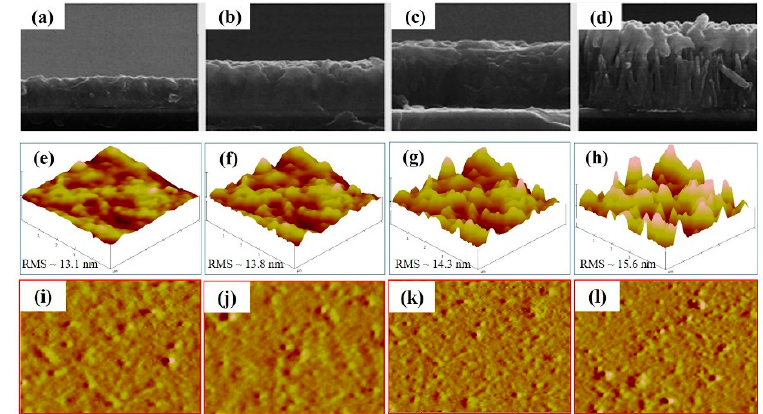
Figure 4. The SEM images of the ( a,b,c,d ) (WA-ZnO/P3HT:PCBM) active layer on ZnO seed layer/ITO/glass, 3D-AFM images of the ( e,f,g,h ) (WA-ZnO/P3HT:PCBM)- and 2D-AFM images of the ( i,j,k,l ) (WA-ZnO/P3HT:PCBM)-active layer on ZnO seed layer/ITO/glass with various reaction time of 1 to 4 h